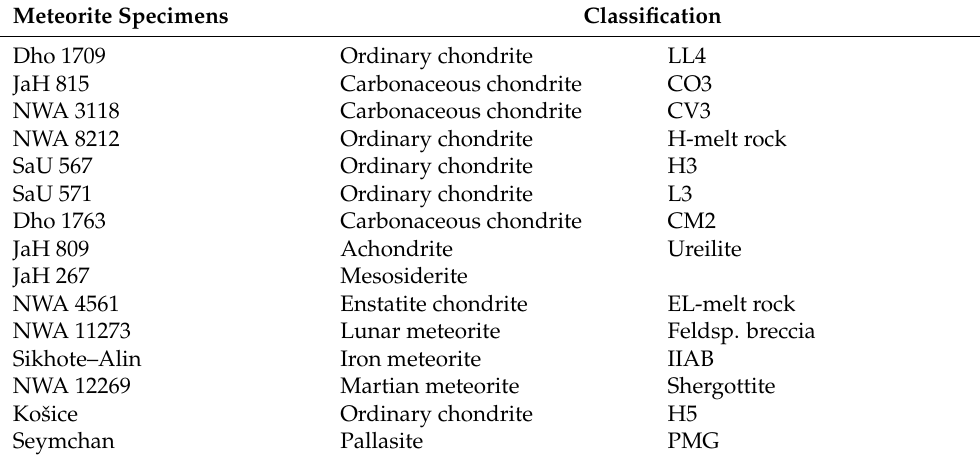
Table 1. List of meteorites used for the interaction